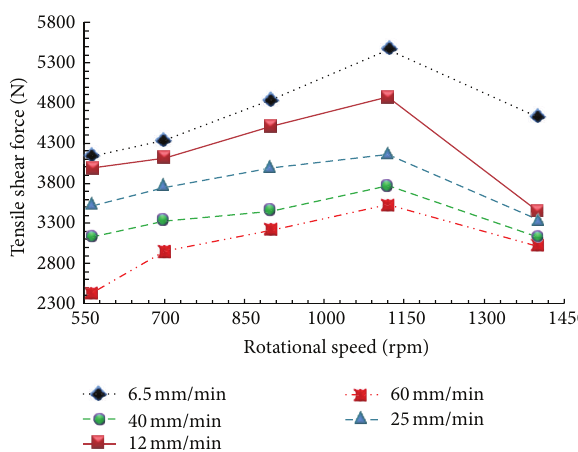
Table 2: Summary of different networks evaluated to yield the criteria of network performance.